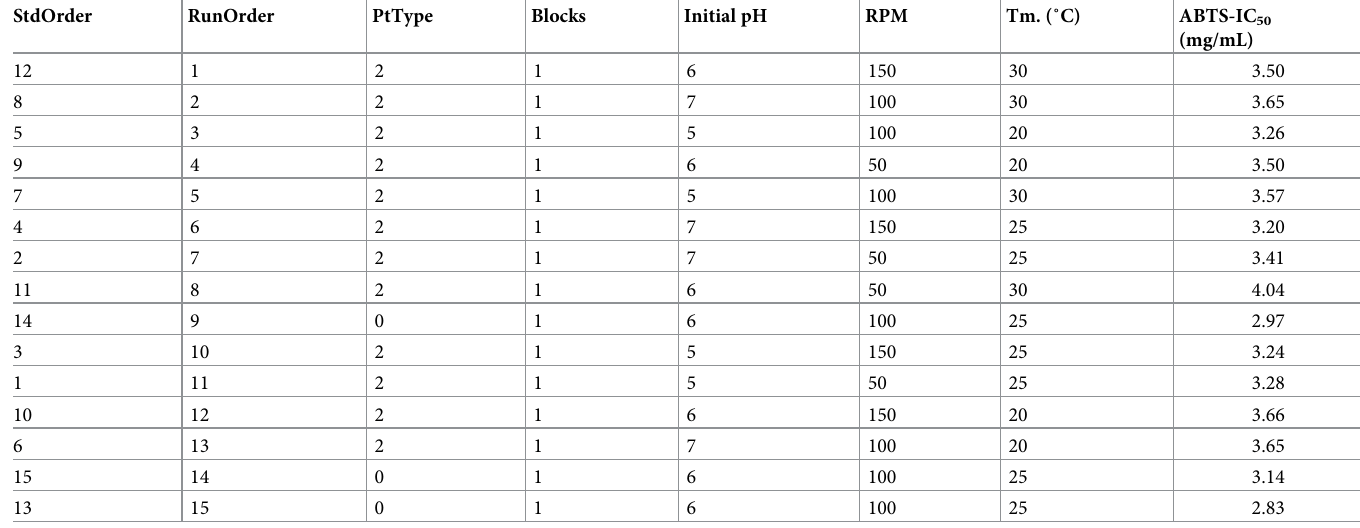
Table 2. Experimental range and values in the central composite design for optimizing the fermentation